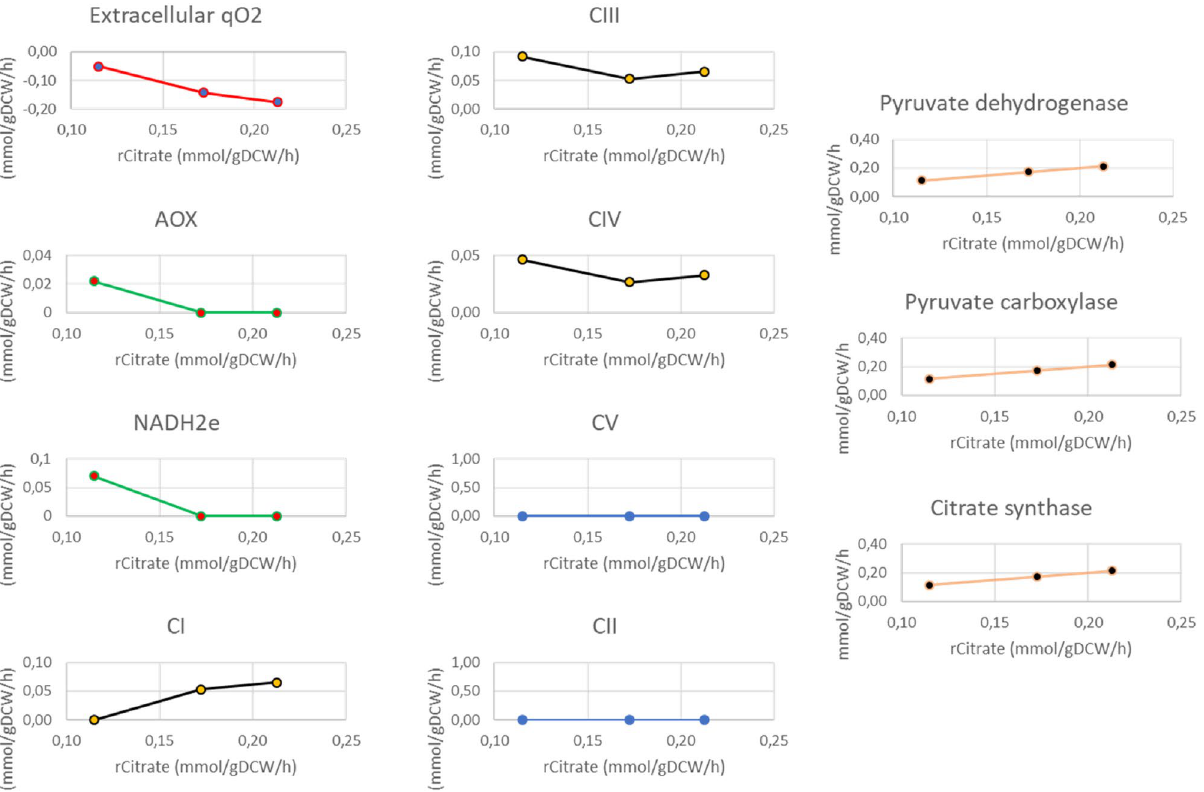
Figure 3. Simulated OXPHOS and enzymes activities at stationary phase with increased citrate production rate. Optimizing citrate production rate is correlated with limited oxygen consumption rate, decreased AOX and NADH2e. Complex I (CI) activity increases for NADH turnover. PDH, PC and CS supports citrate overproduction.